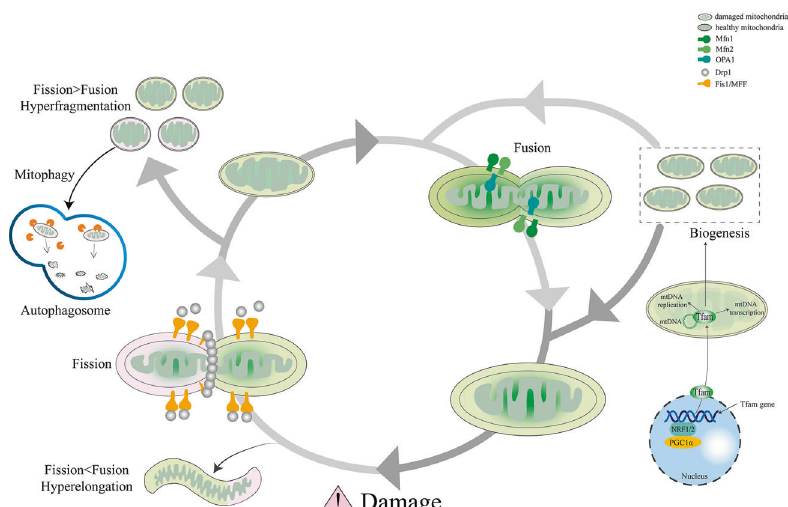
Fig. 3 Consequences of mitochondrial dynamics. Damaged or senescent mitochondria divide into one healthy organelle that fuses with other healthy mitochondria to regenerate the mitochondrial pool and one severely depolarized organelle that is timely eliminated by autophagosomal engulfment. Thereby new mitochondria are generated by biogenesis to replace degraded mitochondria parts. The balance offset between mitochondrial fusion and fi ssion leads to either hyperelongated or hyper fragmented